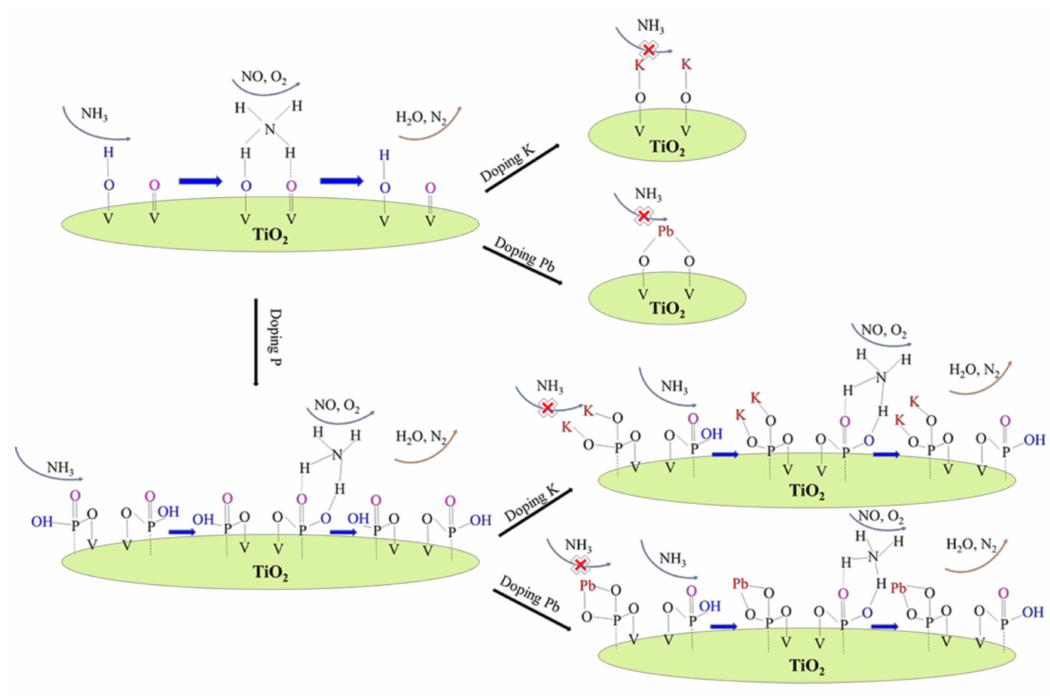
Figure 7. Schematic diagram of the combined e ff ect of phosphorus, potassium and or lead on V 2 O 5 -WO 3 / TiO 2